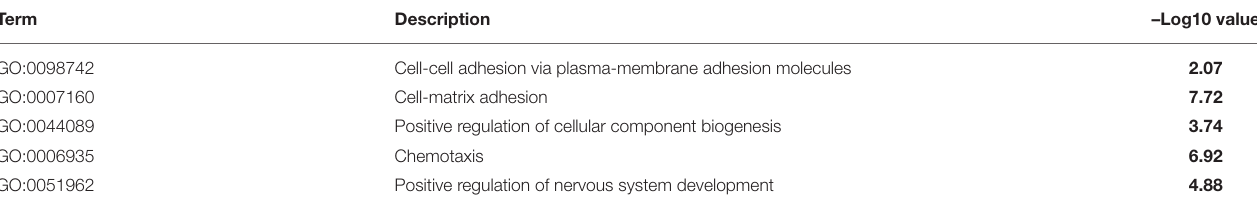
TABLE 4 | AMIGO2 related pathways